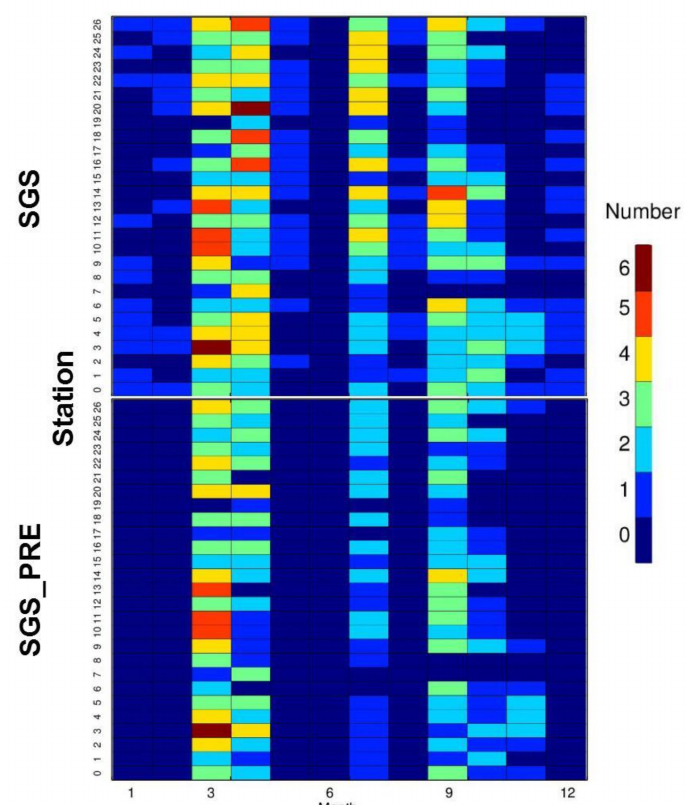
Figure 6. Seasonal dependence of the number of weak ionospheric response events for 27 ionosondes for SGS events (upper panel) and SGS-PRE events (lower panel).